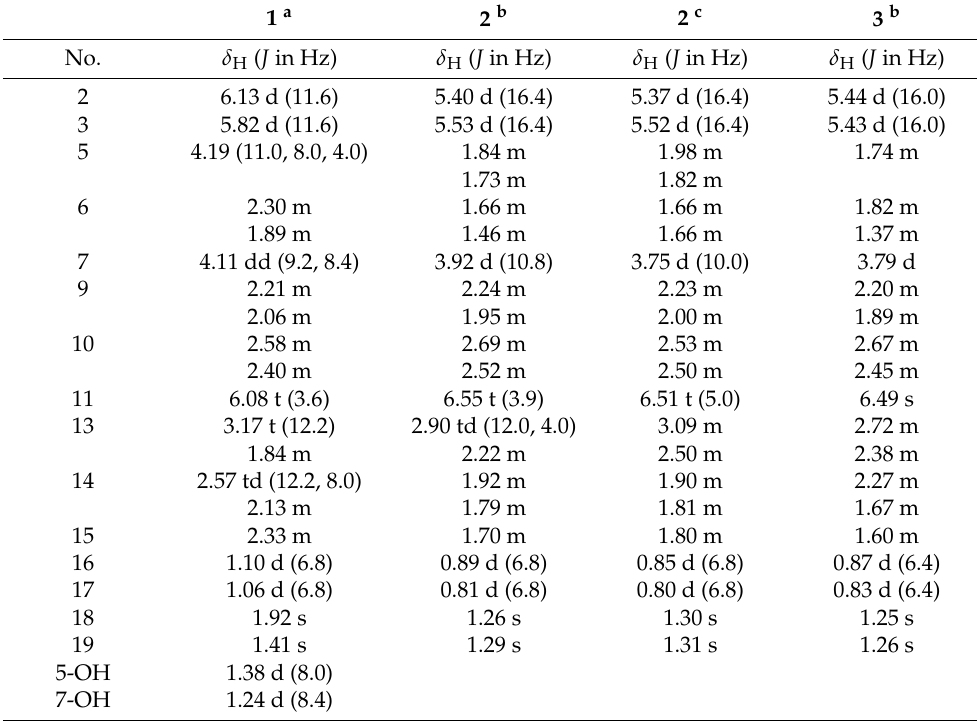
Table 1. 1H NMR spectroscopic data of compounds 1 – 3